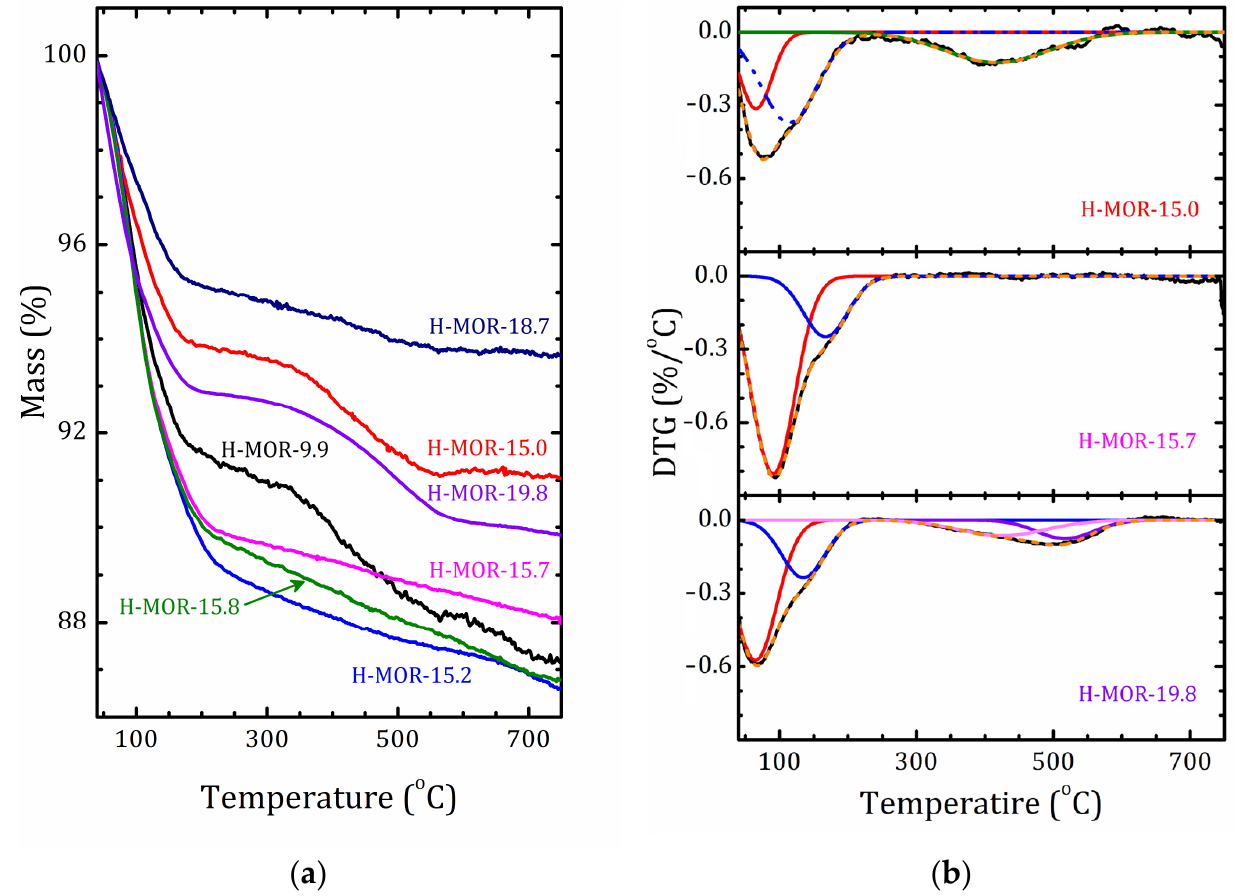
Figure 3. TG curves for all studied samples ( a ) and DTG curves with their decomposition for H-MOR-9.9, H-MOR-15.7, and H-MOR-19.8 ( b ).